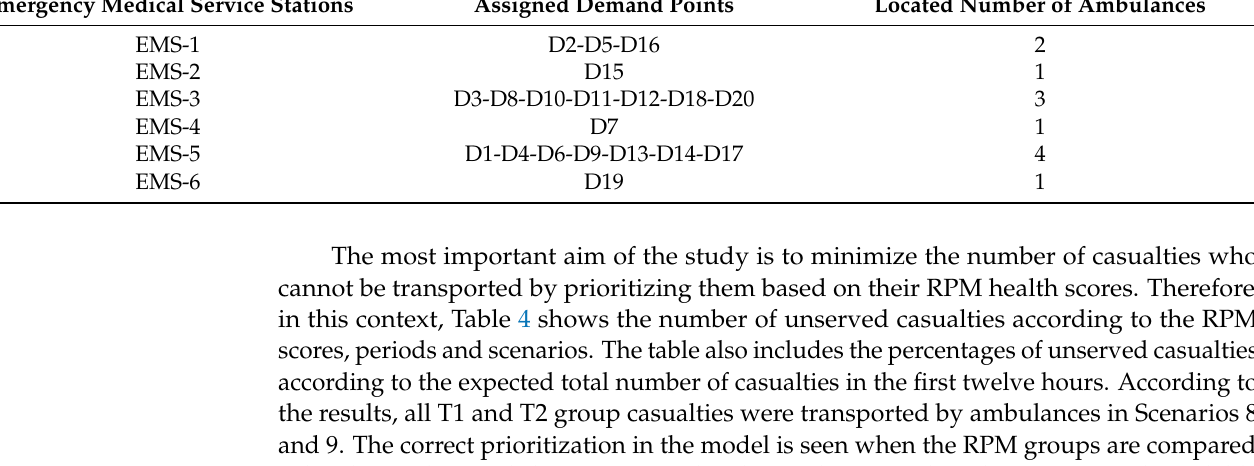
Table 3. The emergency medical system (EMS) coverage and ambulance location-allocation solutions for Kartal case.